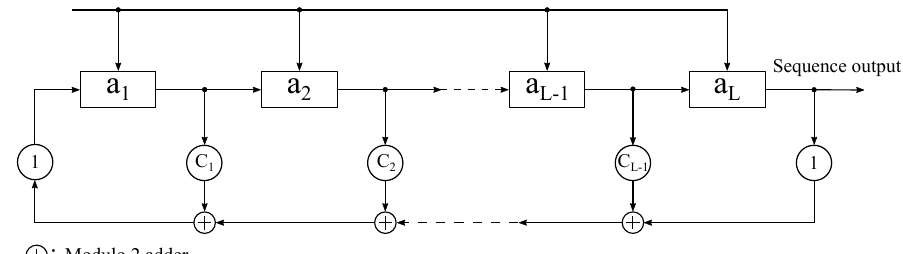
Figure 4. An L-stage linear feedback shift-register for the generation of maximum length sequence (MLS) signals (adapted from Figure 2.1 in [35], published by J. Ross Publishing. All rights Reserved). a i denotes the state of each register, where i ∈ { 1,2,3,...,L }